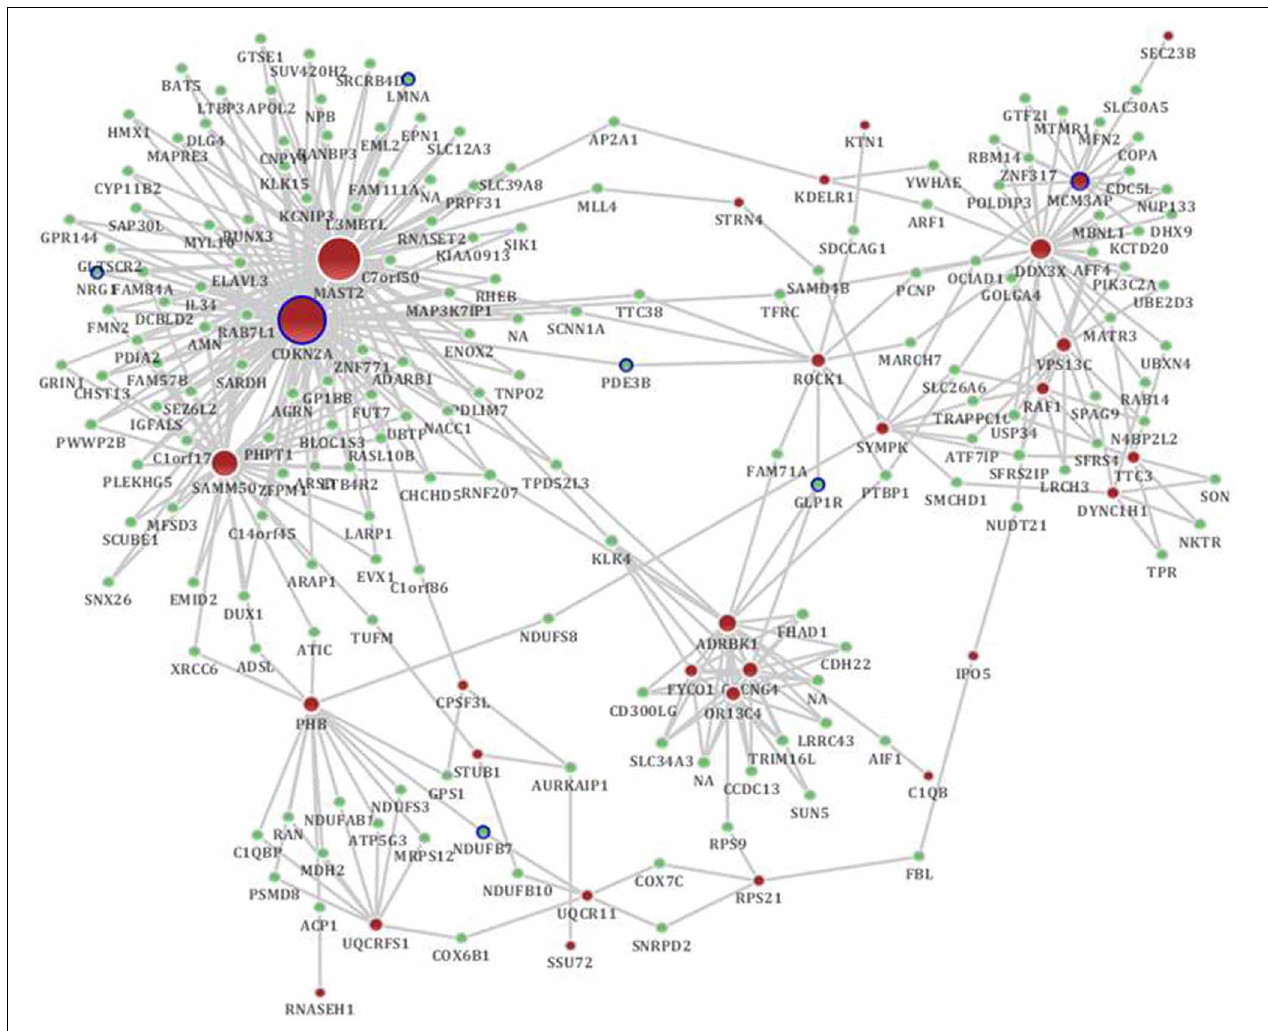
FIGURE 4 | The distinct genetic sub-network of hippocampus and cerebral cortex in SAMP8 mice based on co-expression network. Red nodes represent differential expressed genes in SAMP8 mice, green nodes